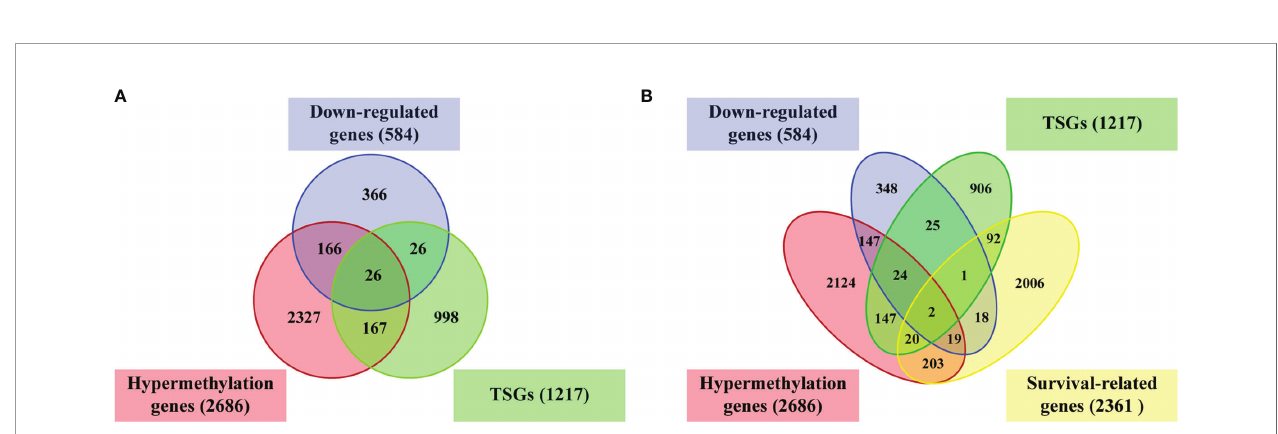
FIGURE 3 | GO and KEGG pathway of the genes relevant to hypermethylation/low expression genes. (A) GO of hypermethylated/down-regulated genes. Names of the top 15 items are indicated by the y-axis. The size of the colored dots is the enriched number of genes in each GO classi fi cation. The red dots indicate high enrichment and the blue dots indicate low enrichment. FDR value is expressed by the color order on the right edge. (B) KEGG pathway enrichment of hypermethylated/down-regulated genes. The size of the dot in the KEGG pathway bubble plot shows the enriched genes. High enriched represented by red, otherwise, by blue.